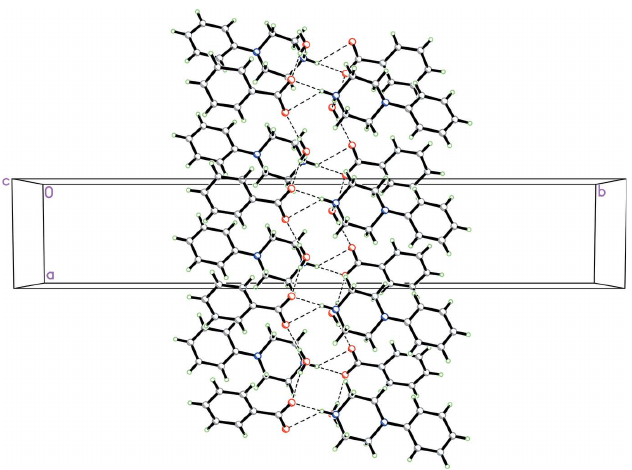
Figure 24 Packing diagram for 9 viewed along the c- axis direction showing the two anti-parallel C 2 (6) chains linked by N—H (cid:2)(cid:2)(cid:2) O and C—H (cid:2)(cid:2)(cid:2) O inter- 2 actions involving the water oxygen atom, which combine to form ribbons in the a- axis